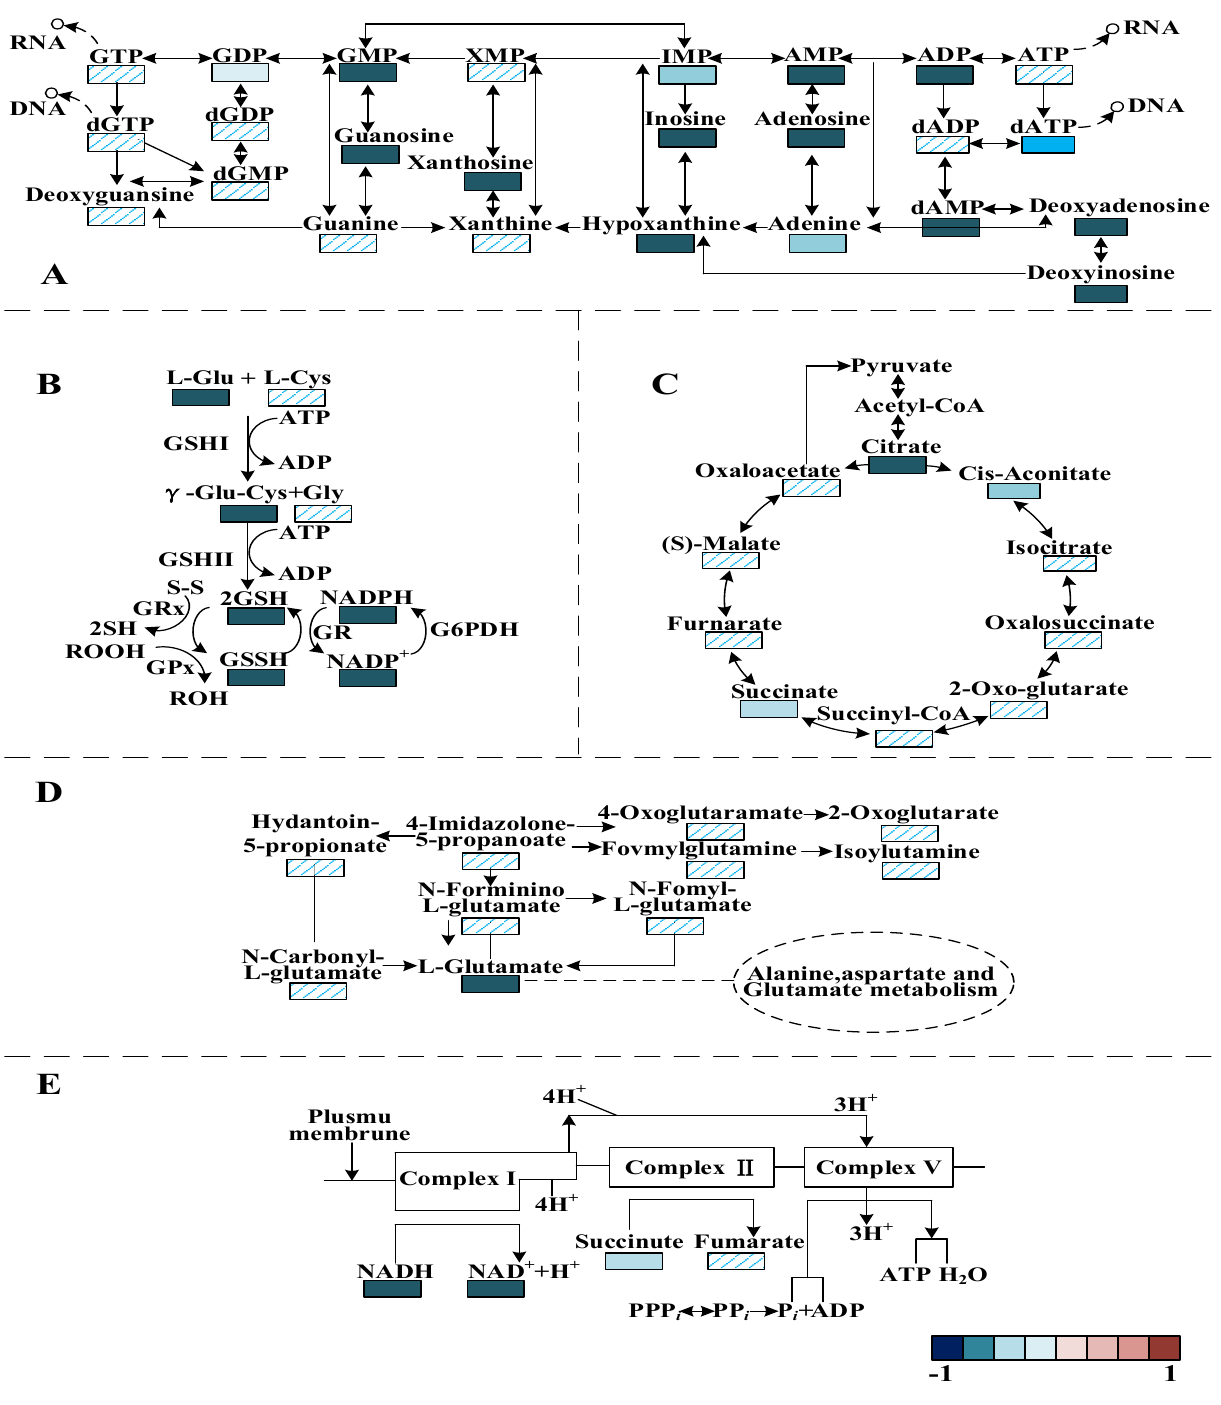
Figure 10. Changes in identified metabolites in response to the PALA exposure in the pathways of purine metabolism ( A ), glutathione (GSH) metabolism ( B ), TCA cycle ( C ), alanine, aspartate and glutamate formation ( D ) and oxidative phosphorylation metabolism ( E ). The colors represent the metabolite abundance ratio of the PALA treatment and the control. Red is upregulated; blue is downregulated. blue is